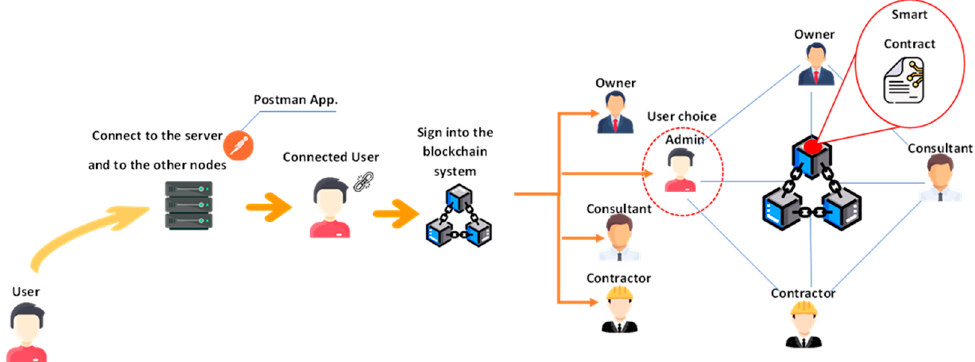
Figure 5. Prototype’s overall workflow.